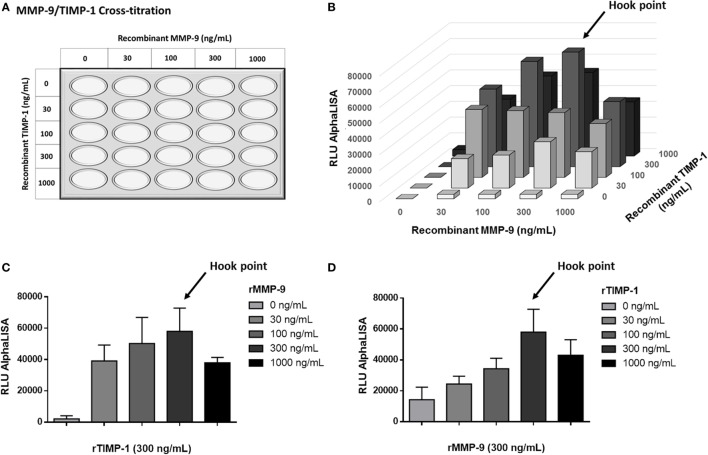
AlphaLISA® matrix metalloproteinase (MMP)-9–tissue inhibitor of metalloproteinase (TIMP)-1 interaction immunoassay for detecting recombinant MMP-9 (rMMP-9) and TIMP-1 proteins. (A) Schematic illustration of the cross-titration MMP-9–TIMP-1 template. MMP-9 and TIMP-1 concentrations from 0 to 1,000 ng/mL were used for the optimization of the technique. (B) Results of the rMMP-9–TIMP-1 interaction immunoassay expressed as binding RLU (relative luminescence units) using different concentrations of MMP-9 and TIMP-1 (0, 30, 100, 300, and 1,000 ng/mL). (C) Curve 0–1,000 ng/mL of MMP-9 with a fixed dose of 300 ng/mL TIMP-1. (D) Curve 0–1,000 ng/mL of TIMP-1 with a fixed dose of 300 ng/mL MMP-9. (C,D) assays were repeated twice. Hook point is reached at 300 ng/mL MMP-9 and 300 ng/mL TIMP-1.